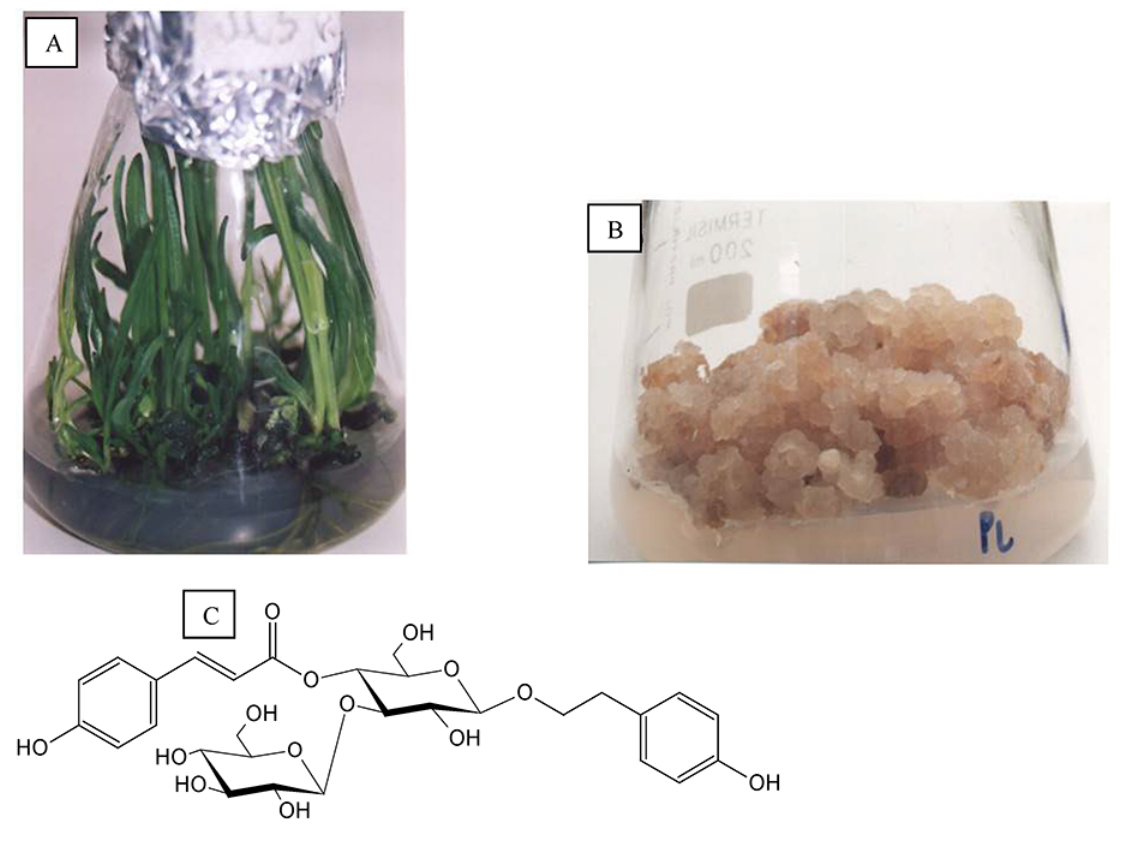
Figure 4 In vitro Plantago lanceolata ( A ) leaf rosettes, and ( B ) callus cultures. ( C ) Lancetoside structure.